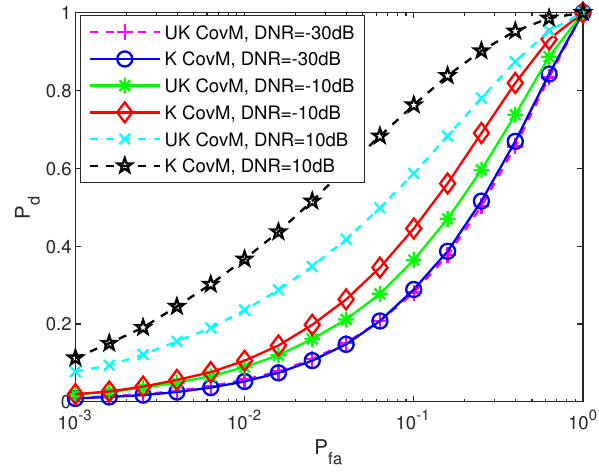
Figure 3. P d vs. P fa (TNR = − 15 dB, K =